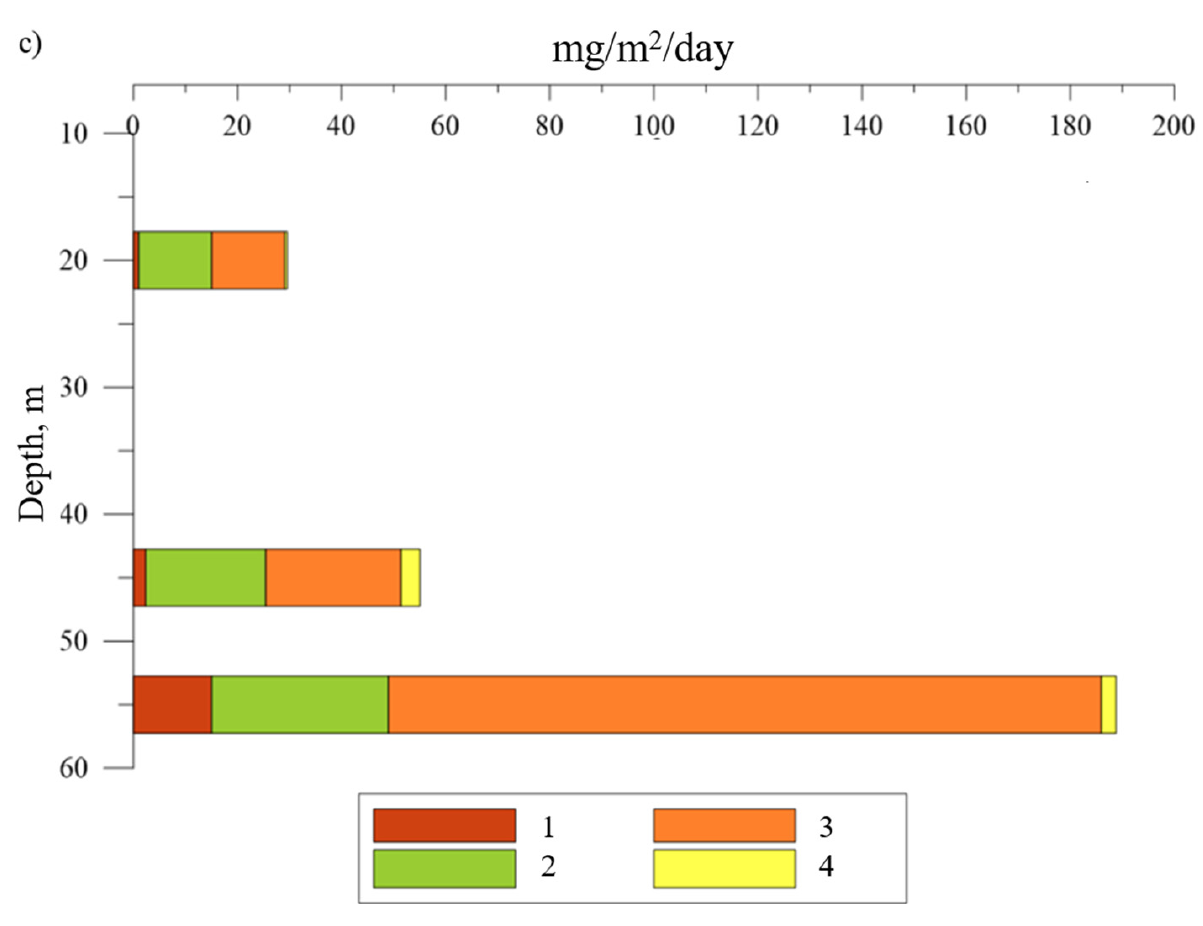
Figure 6. The material composition of suspended matter in sediment traps at stations 5942 ( a ), 5945 ( b ) и 5946 ( c ). 1 —organic matter; 2 —amorphous particulate silica; 3 —lithogenic matter; 4 —calcium carbonate.